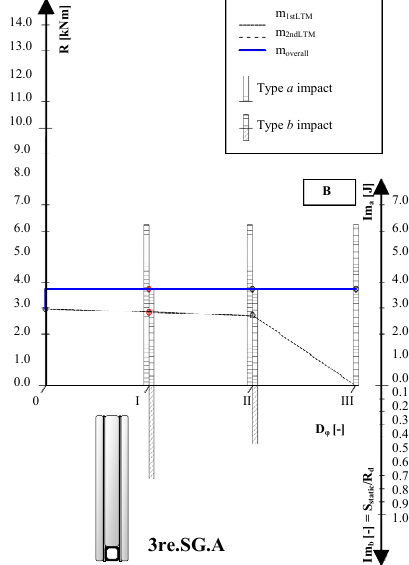
Figure 16: Element Safety Diagram for triple layer, SG-laminated, annealed glass